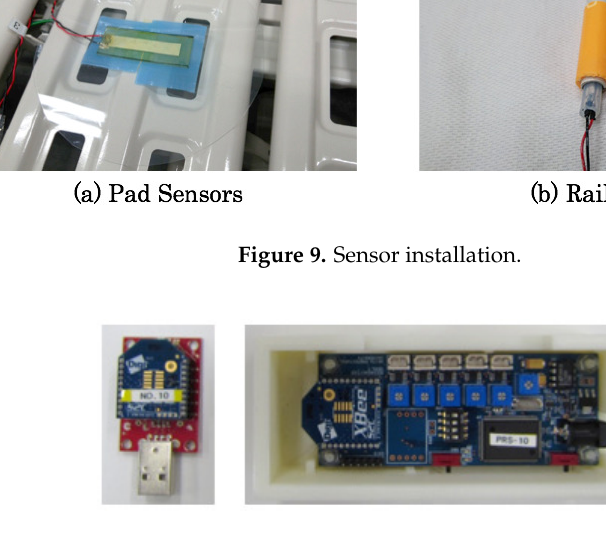
Figure 10. Sensor measurement board with ZigBee